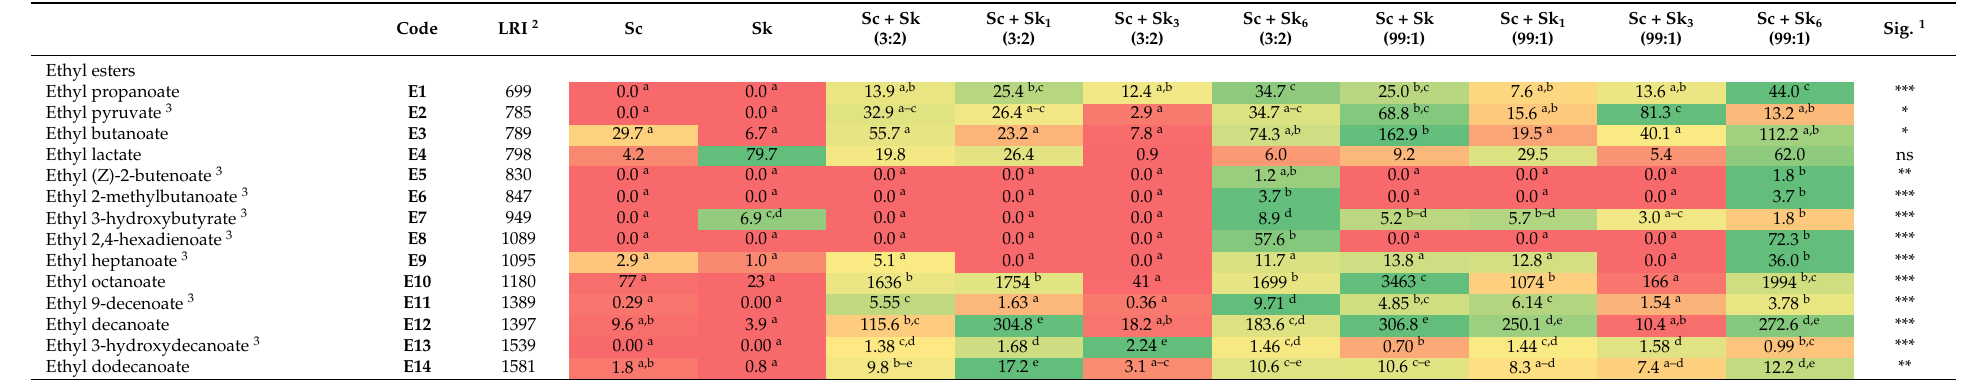
Table 3. A heat map of 89 volatile components [ µ g/L] produced by pure and mixed cultures of S. cerevisiae (Sc) and S. kudriavzevii (Sk). The highest concentration of a specific compound in a row is marked in dark green and the lowest content is marked in dark